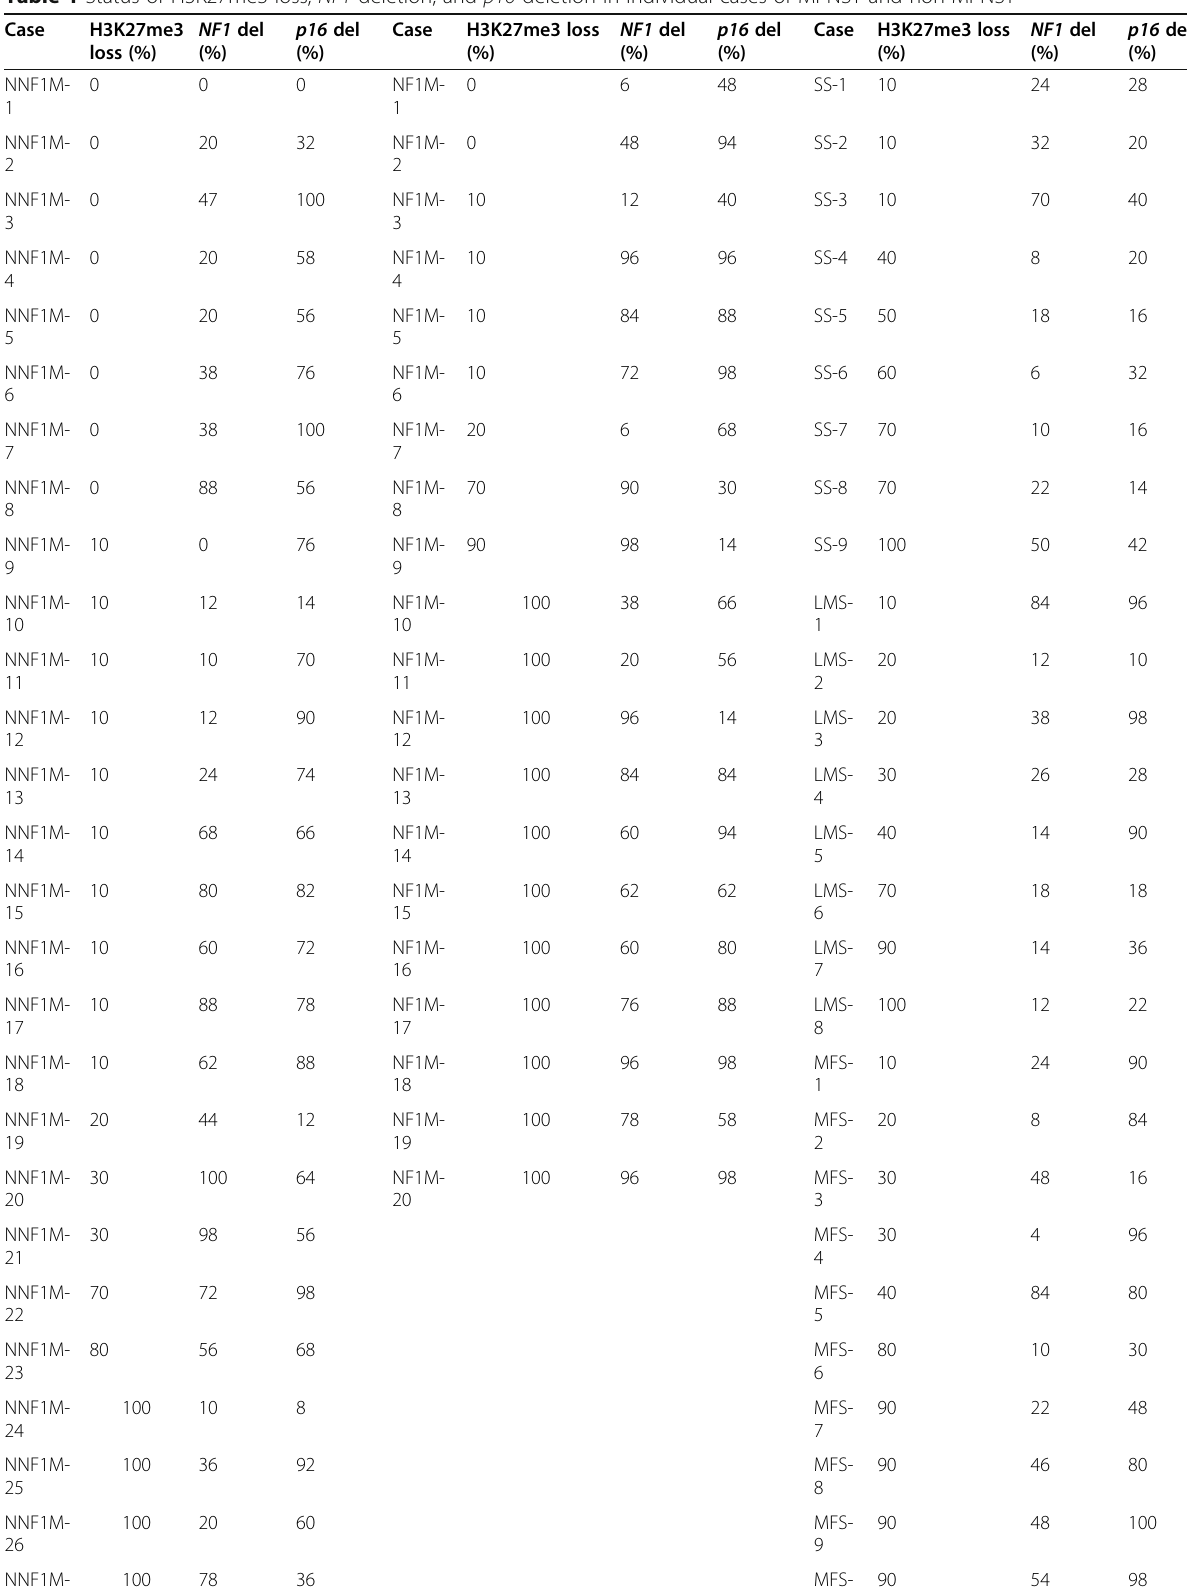
Table 1 Status of H3K27me3 loss, NF1 deletion, and p16 deletion in individual cases of MPNST and